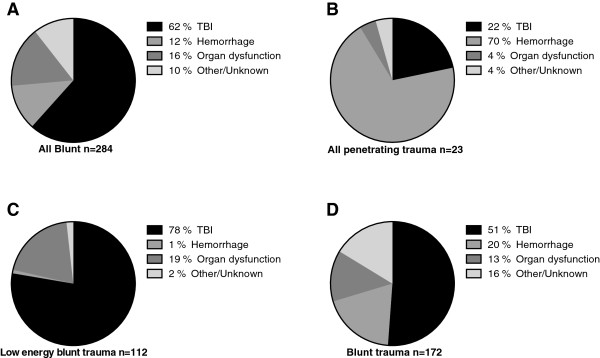
Causes of death in deaths owing to blunt trauma (A), penetrating trauma (B), low energy blunt trauma (C) and other blunt trauma (D).